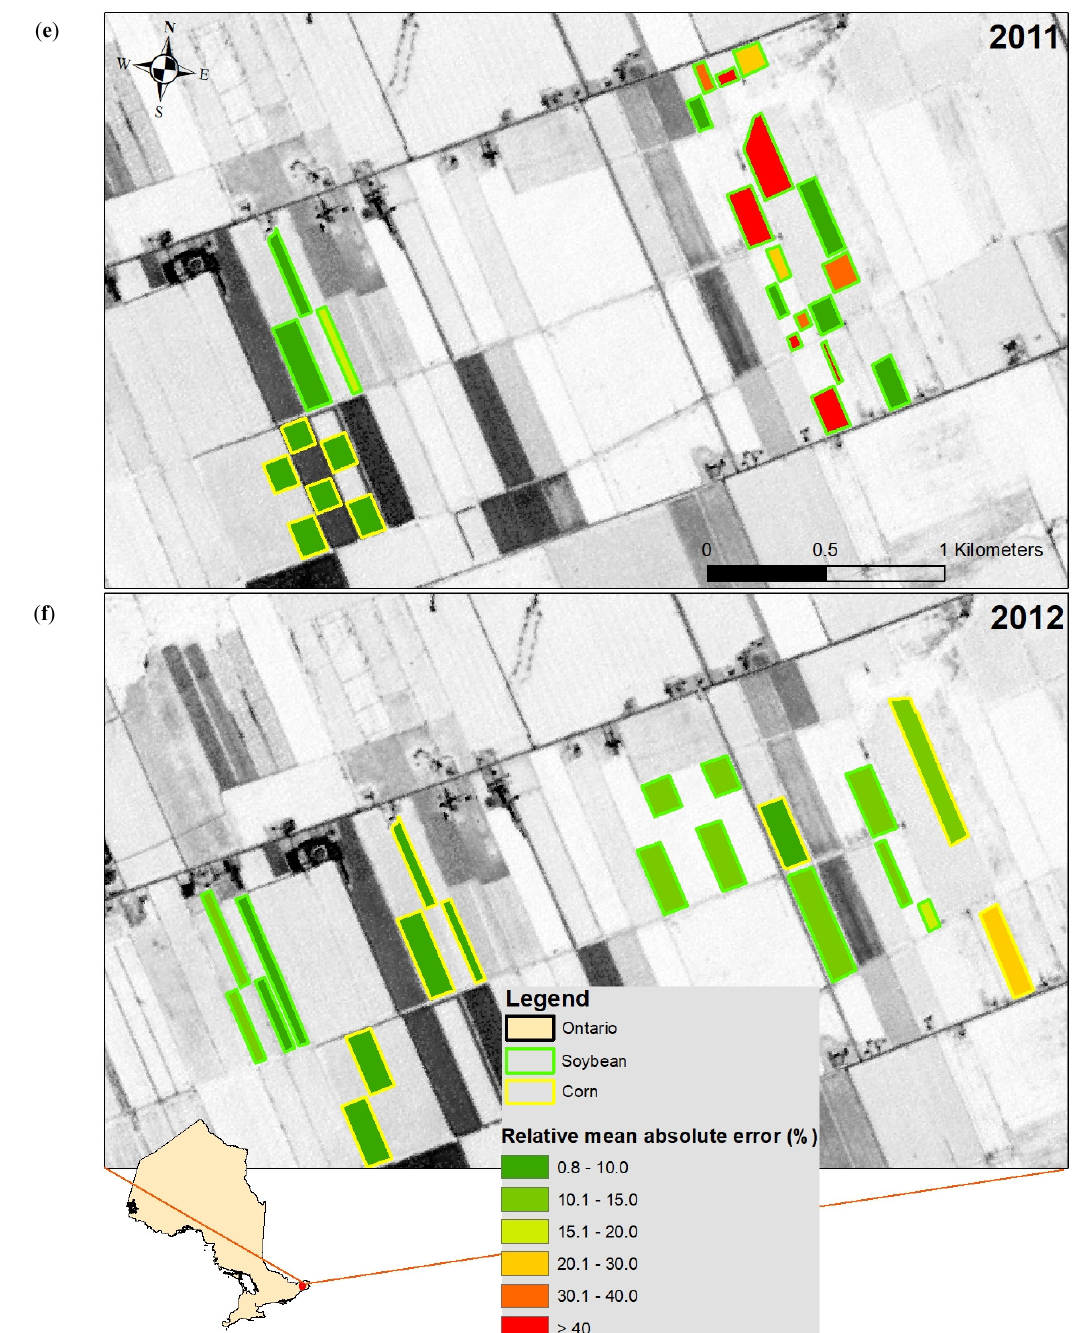
Figure 7. Overview of the results from the ANN models for 2011 ( a ) and 2012 ( b ). Results show the predicted crop yield of the models that were trained and tested with one crop, in one year. Overview of the results from the ANN models for 2011 ( c ) and 2012 ( d ). Results show the relative errors ((pixel error / field yield mean) * 100) of the models that were trained and tested with one crop, in one year. Overview of the results from the ANN models for 2011 ( e ) and 2012 ( f ). Results show the errors ((field mean error / field yield mean) * 100) of the models that were trained and tested with one crop, in one